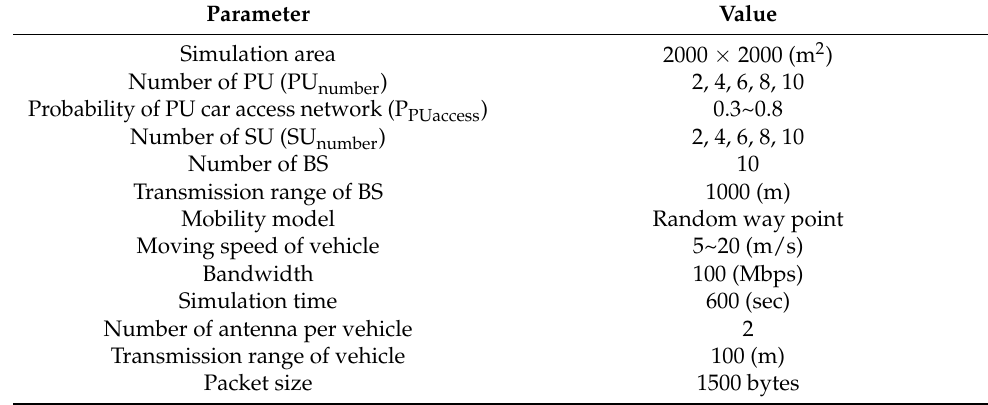
Table 1. Simulation